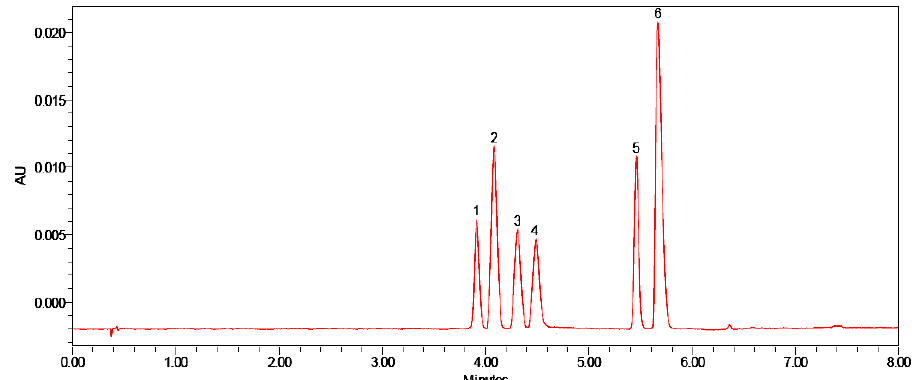
Figure 2. UPLC-PDA chromatograms of mixed standard